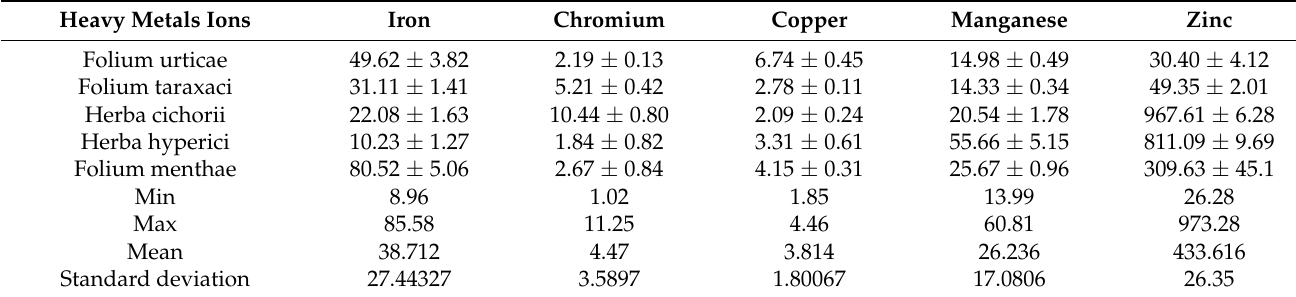
Table 1. Mineral elements in the studied plants ( µ g g − 1